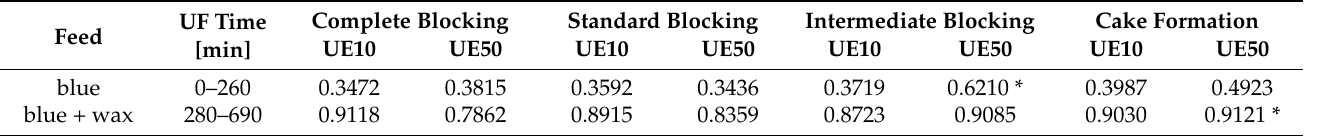
Table A1. Coefficient of determination (R 2 ) Hermia’s model. The UF process with the constant feed concentration (Figure 5).